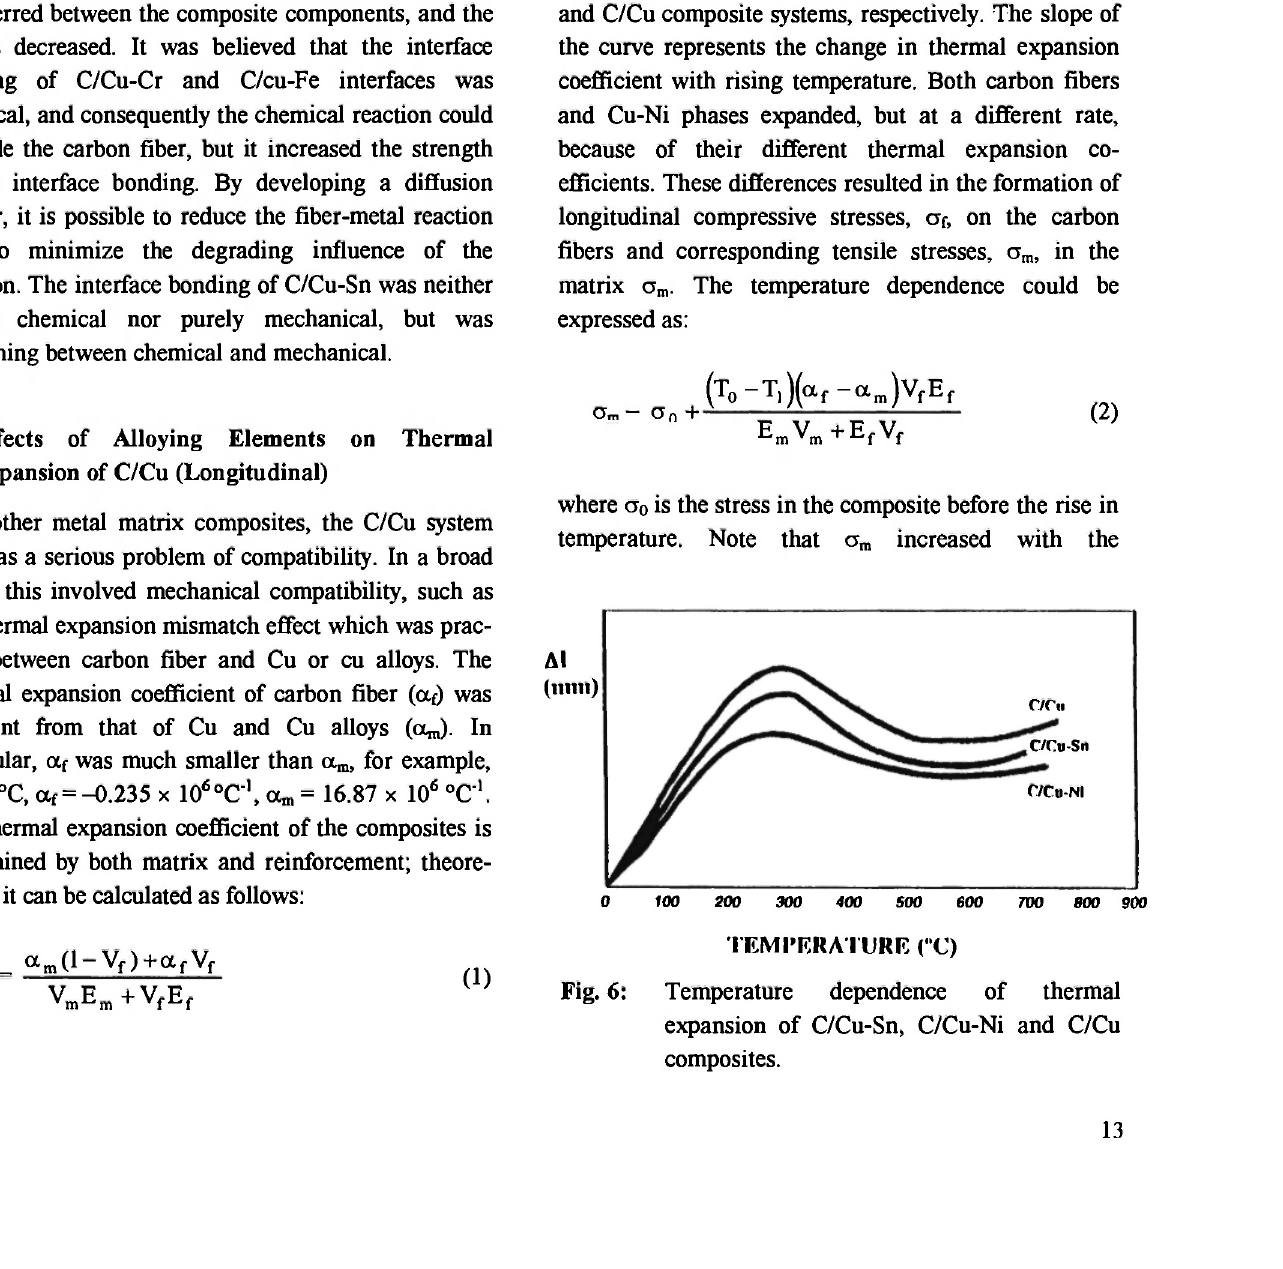
Temperature dependence of thermal expansion of C/Cu-Sn, C/Cu-Ni and C/Cu